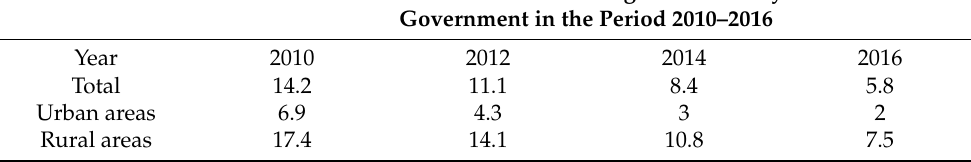
Table 1. Proportion of poor households by urban—rural areas in the period 2010–2016. The Rate of Poor Households According to the Poverty Standard of the Government in the Period 2010–2016